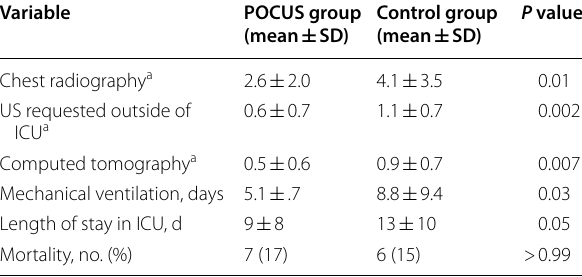
Echo echocardiography, ICU intensive-care unit, US ultrasound a